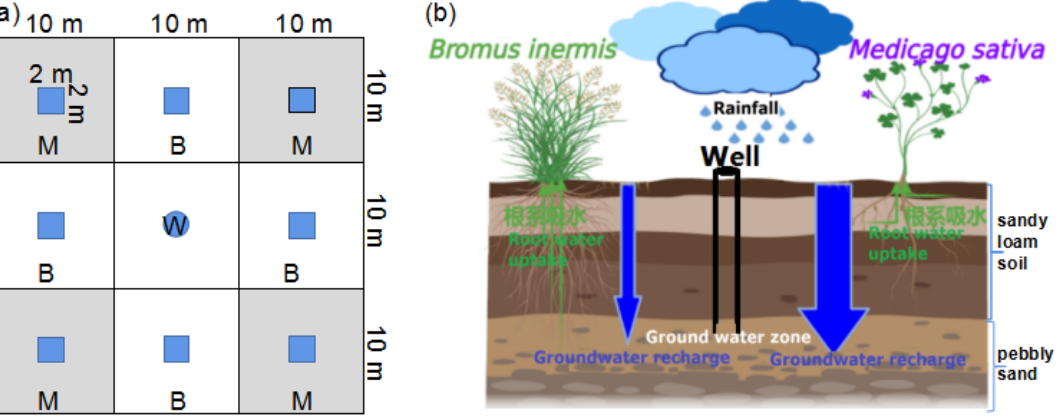
Figure 2. Sampling scheme. ( a ) Experimental plots (M—Medicago sativa, B—Bromus inermis, and W—Well). ( b ) Soil horizons and aquifer.